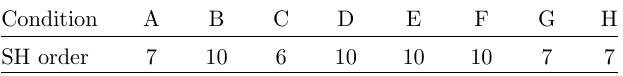
Table 1. Spherical harmonics order at which the participants rated the stimuli signi fi cantly different than the reference (SH order 35). A to C: Male voice, meeting room, head orientation of